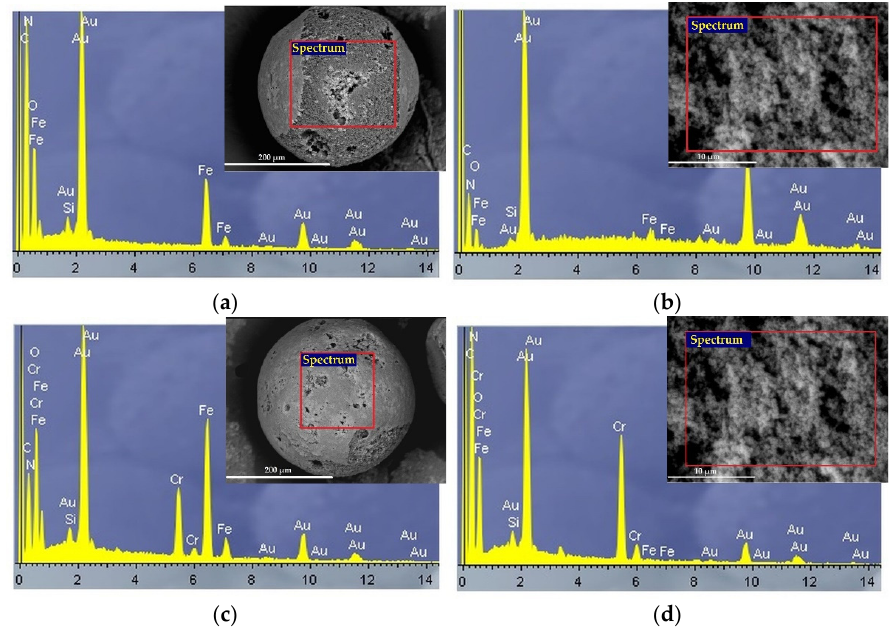
Figure 8. EDX spectra and SEM images for Fe 3 O 4 @APTMS/PGME-deta of ( a ) particle surface and ( b ) cross-section before sorption and ( c ) particle surface and ( d ) cross-section after chromium sorption.